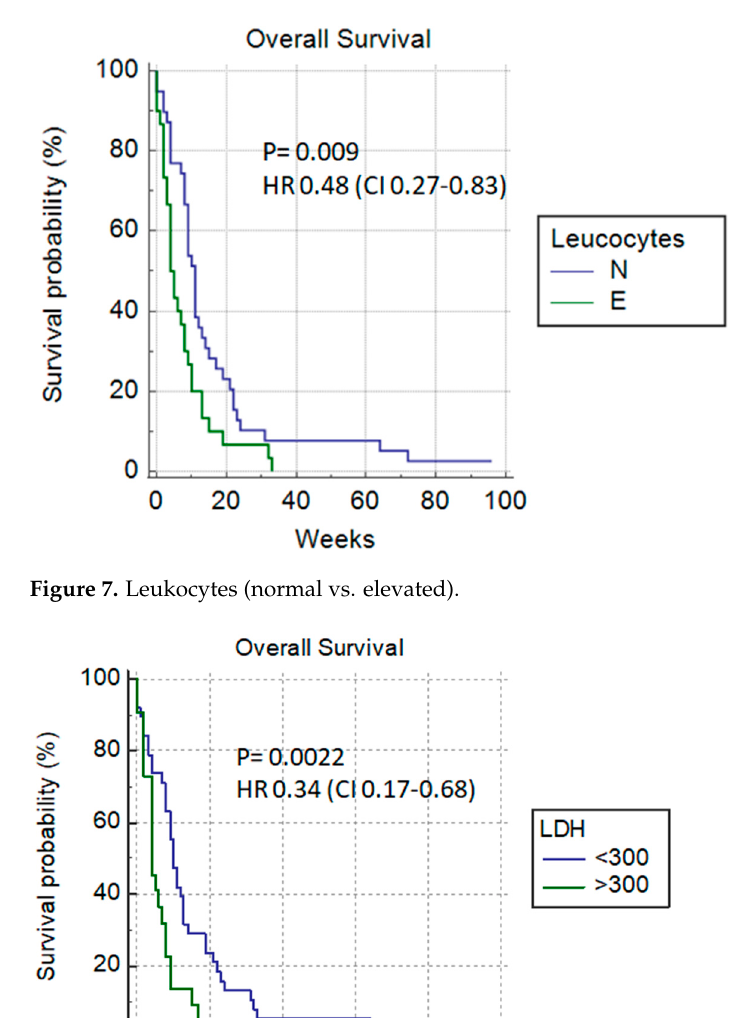
Figure 6. Median overall survival rate.